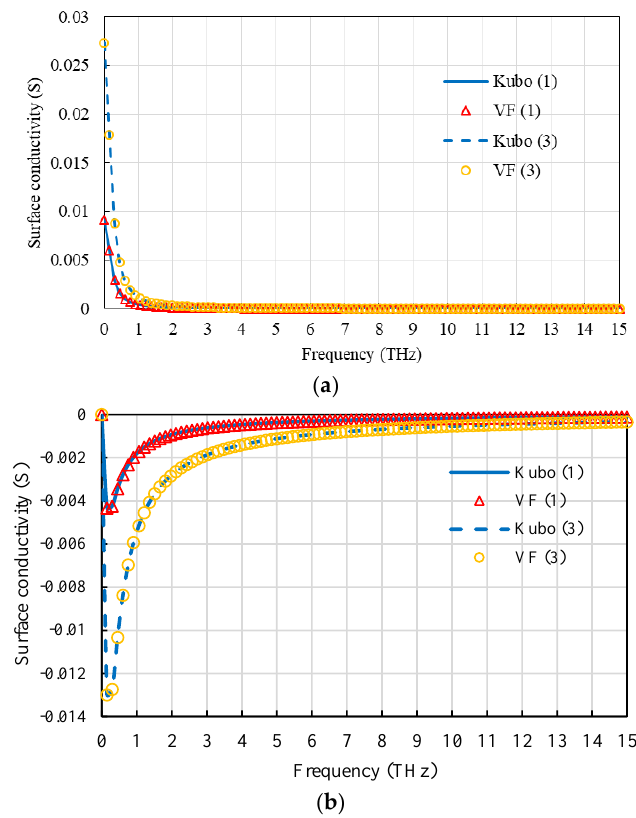
Figure 3. Monolayer and trilayer graphene surface conductivity: ( a ) real parts; ( b ) imaginary parts.